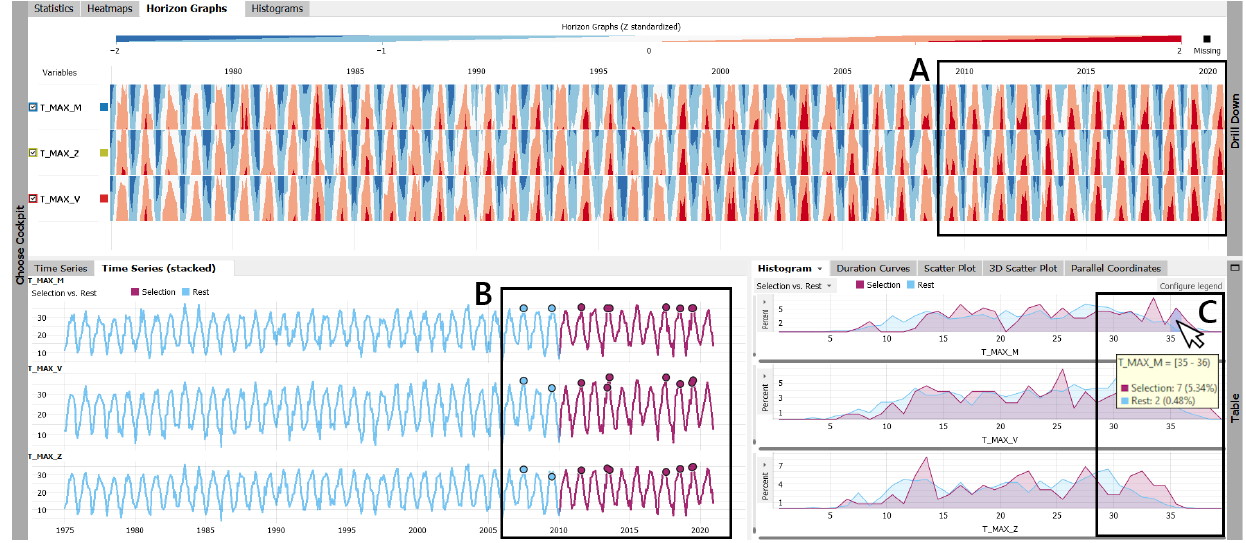
Figure 3. Warming progression denoted for the air temperature maxima with higher frequency of temperatures exceeding 35 °C in the past 10 years in comparison to the remaining 35 years: ( A ) the observed higher representation of temperature peaks marked in red; ( B ) the highlighted individual data points denoting instances of air temperature exceeding 35 °C; ( C ) shifting of the frequency area towards generally higher values for temperature maxima.